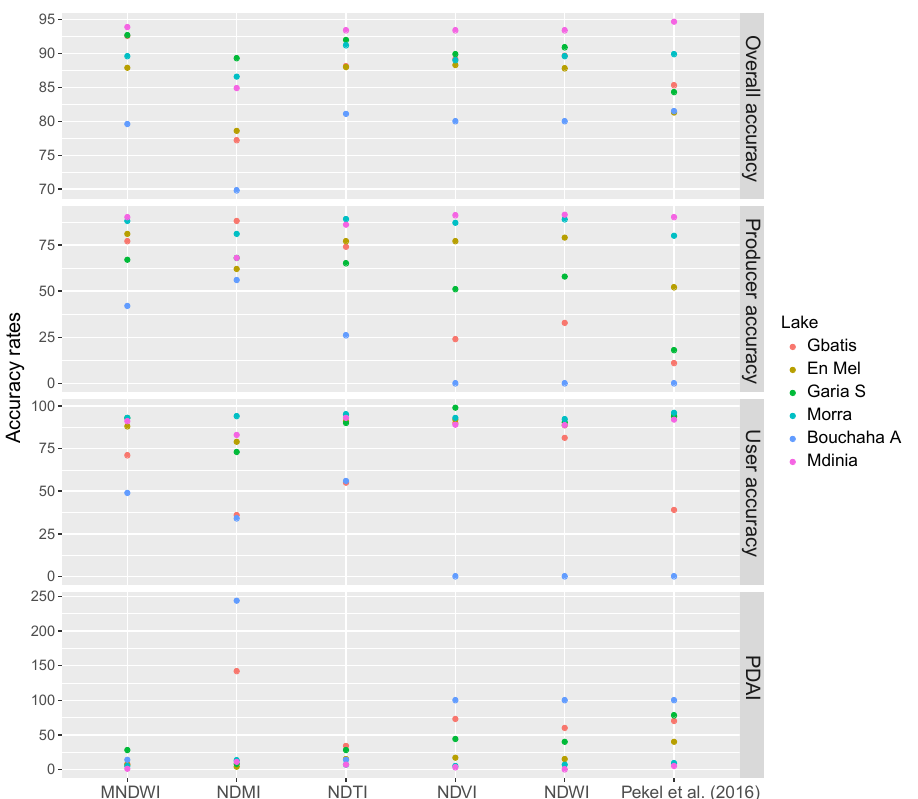
Figure 7. Accuracy and error values for five spectral water indices and the (Pekel et al., 2016) expert systems approach on the May validation image.